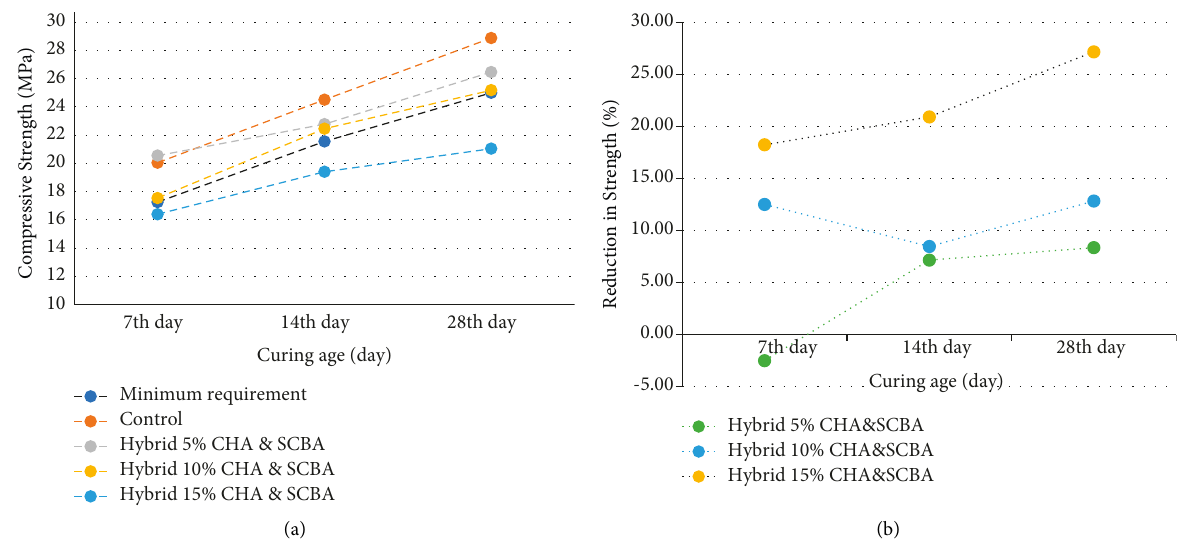
Figure 9: (a) Compressive strength of test specimens and (b) reduction in compressive strength of partially replaced cement concerning control specimen.